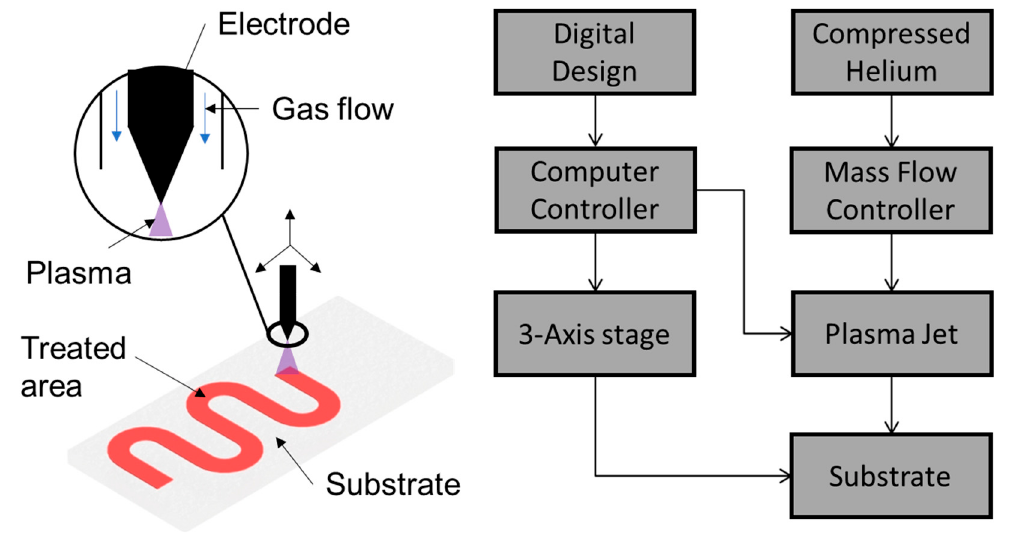
Figure 1. Selective plasma treatment platform overview.